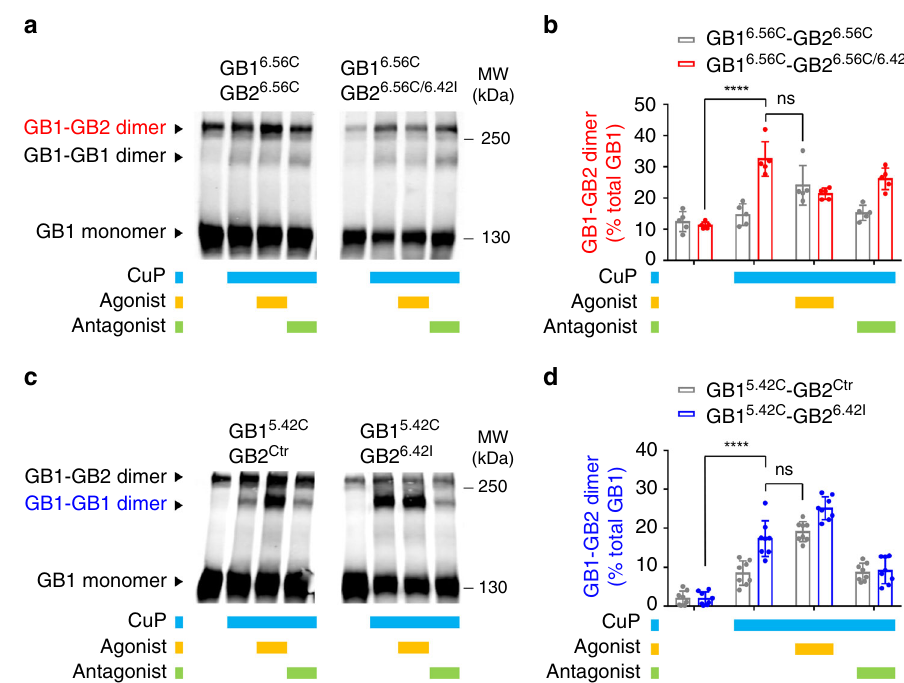
Fig. 8 A disease-causing mutation stabilizes the active interface of the dimer and oligomer. a , b Quanti fi cation of the GB1-GB2 cross-linking for the GB1 6.56 and GB2 6.56 cysteine mutants containing or not the genetic mutation S695I 6.42 in the GB2 subunit, in the indicated conditions and as described in Fig. 3. Both cysteine mutation and the genetic mutation have been introduced in the rat GB1 Ctr and GB2 Ctr . c , d Quanti fi cation of the GB1-GB1 cross-linking for the GB1 5.42 single cysteine mutant co-expressed with GB2 Ctr containing or not the genetic mutation S695I 6.42 . GABA and CGP54626 were used at 100 μ M. Data are mean ± SD from at least three independent experiments ( n = 3 – 5). Unpaired t test with Welch ’ s correction with **** P < 0.0001, or not signi fi cant (ns)